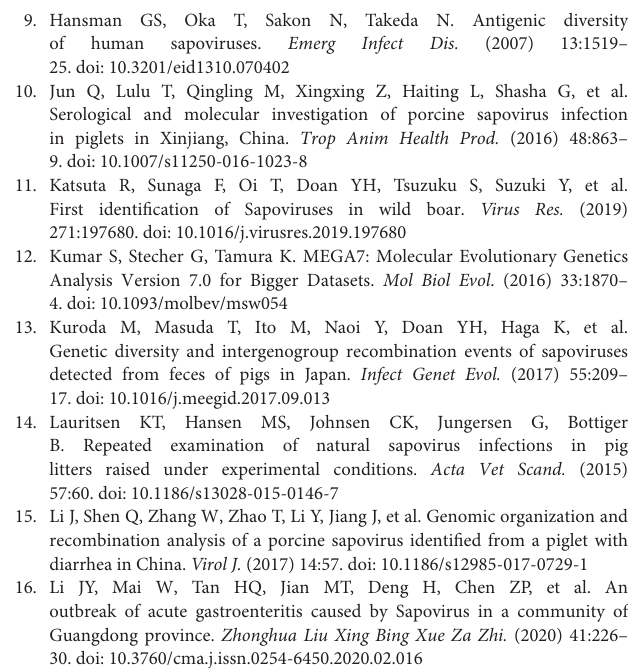
Supplementary Figure S1 | Nucleic acid sequence comparison of capsid protein genes ( VP1 and VP2 ) between the 38 selected PoSaV-GIII reference sequences ( Supplementary Table S3 ) and the 20 Yunnan PoSaV-GIII strains (indicated with solid blue squares, Supplementary Table S4 and Supplementary File ) by using DNAStar 6.0 software with the default parameters. Cluster numbers highlighted in red correspond to the phylogenetic analysis shown in Figure 2 . The numbers in the sequence comparison table present the sequence dissimilarity. The numbers in hollow red squares show the lowest and highest sequence disparity between the 20 Yunnan PoSaV-GIII strains, whereas the numbers in hollow black squares display the lowest and highest sequence discrepancy between the 20 Yunnan PoSaV-GIII strains and the 38 selected PoSaV-GIII reference sequences. Supplementary Figure S2 | Recombination analysis of Yunnan PoSaV-GIII strain YNAN using RDP v.4 software. Phylogenetic tree was constructed based on the complete SaV genomic sequences using the unweighted pair-group method (UPGMA) ( 45) to illustrate the evolutionary relationship between the recombinant strain YNAN (highlighted in red block) and a major parent strain with similar sequence to MK965898 (highlighted in green block) in the region of 1–5195 and 6352–7583 nt (A) , and between the recombinant strain YNAN (highlighted in red block) and a minor parent strain with similar sequence to FJ387164 (highlighted in blue block) in the region of 5196–6351 nt (B) . (C) Analysis of the complete genomic sequences of MK965898 (green line) and FJ387164 (pink line), with YNAN as the query sequence. Red, green, and blue color shades are used to label the recombinant, potential major, and potential minor parent strains on each tree, respectively. In the RDP plots, turquoise blue lines are potential major parent-recombinant; purple lines are potential minor parent-recombinant; yellow lines are potential major parent-potential minor parent. The value below the red barcode indicates the confidence of the RDP analysis, with the smaller value standing for higher